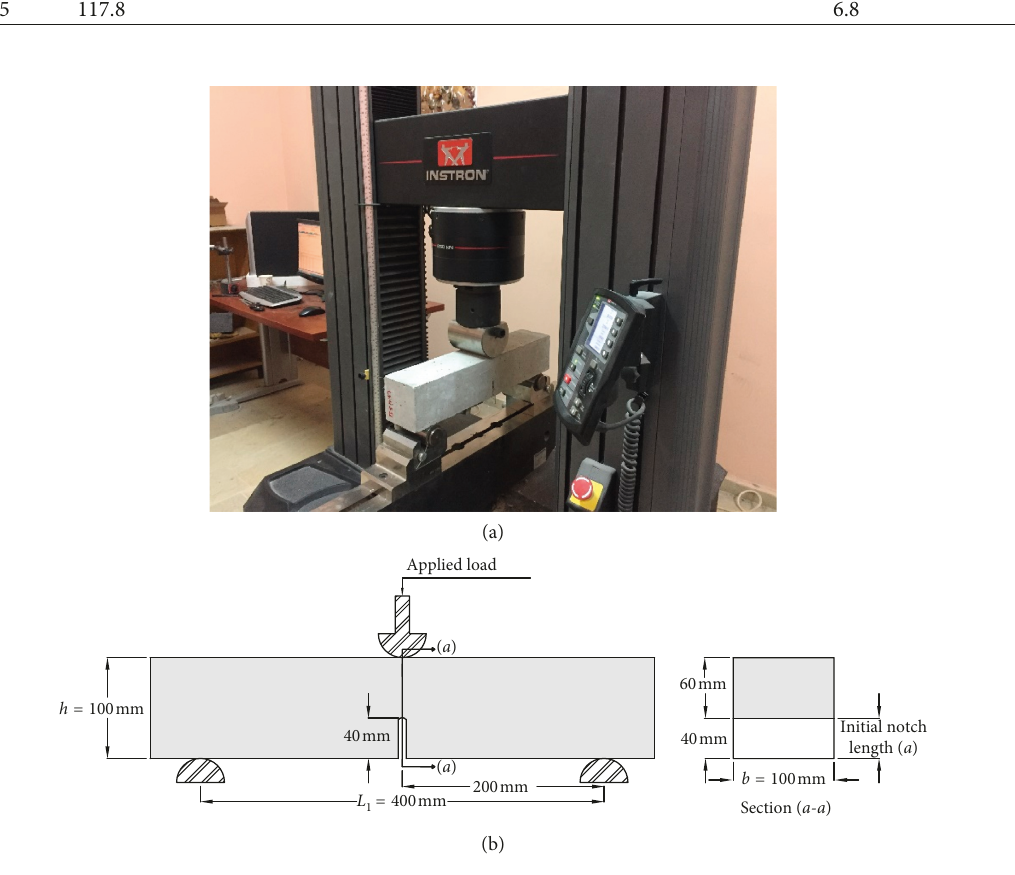
Figure 1: Specimen geometry and test setup for fracture energy.